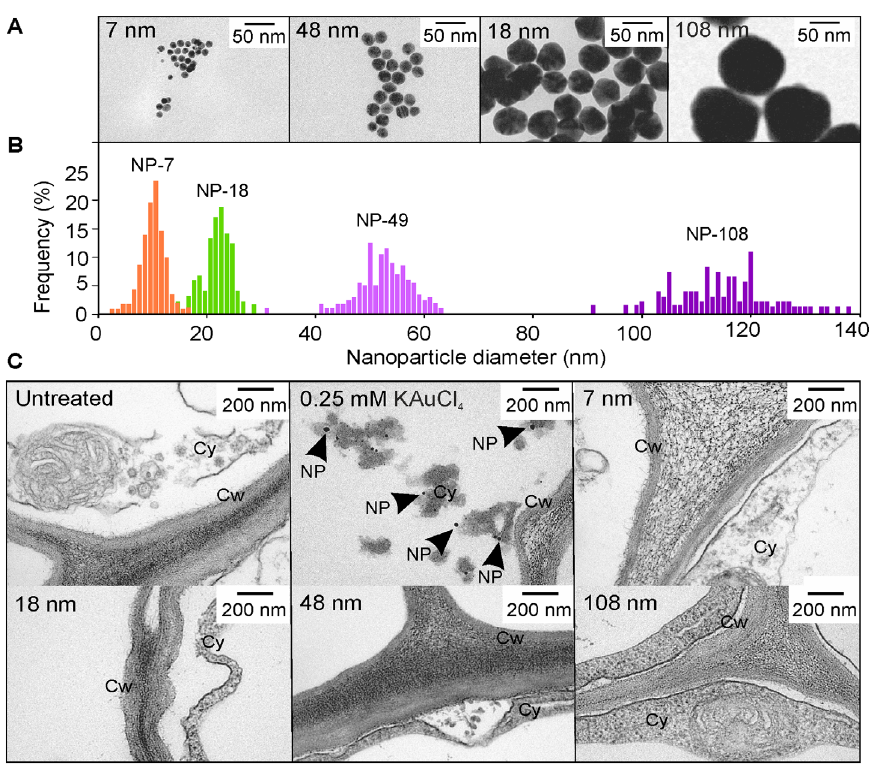
Figure 6. Nanoparticle uptake by alfalfa seedlings. (A) Transmission electron microscopy and (B) size frequency distribution of commercially obtained gold nanoparticles. (C) Transmission electron microscopy of five-day-old alfalfa seedlings 24 h after treatment with ionic gold, as K(AuCl 4 ), or nanoparticles. Nanoparticle treatments were of equivalent molarity to the control 50 mg/L gold, as K(AuCl 4 ). Three seedlings were sectioned at each treatment. NP, nanoparticle; Cy, cytoplasm; Cw, cell